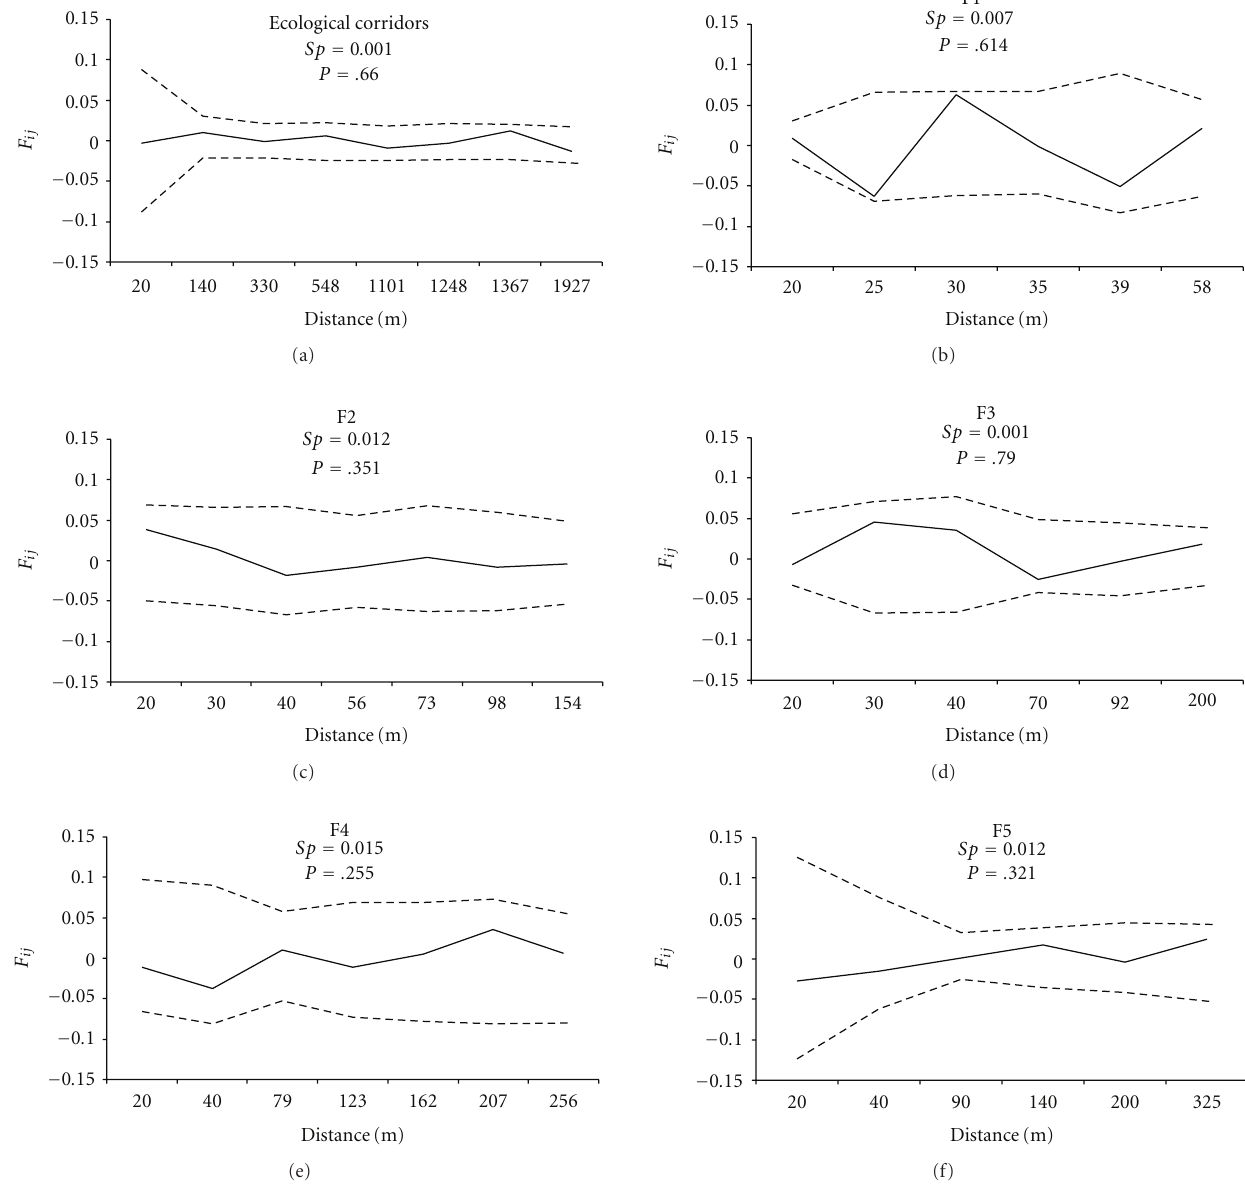
Figure 3: Correlograms of coe ffi cient of coancestry ( F ij ) per distance classes in fragments (F1 to F5) and ecological corridors. Confidence intervals around each F ij -value were obtained through a jackknife procedure over